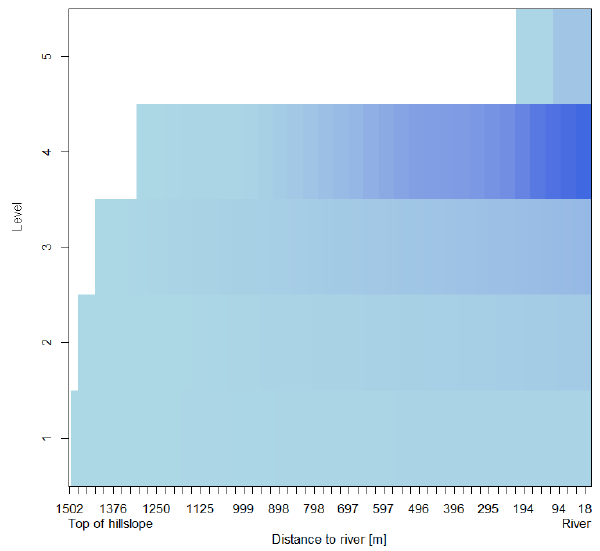
Figure 11. Snapshot of the saturated zone S of the DDD model. The catchment is represented as one hillslope. The x axis shows the distance from the river (right-hand side) to the top of the hillslope (left-hand side). The y axis show the storage levels. The darker the blue colour, the more water is present in the storage